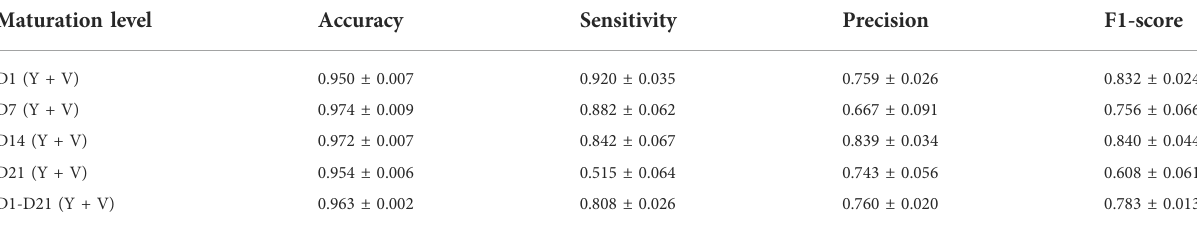
TABLE 1 Performance of the trained classi fi er. The classi fi er was evaluated in terms of its accuracy, sensitivity, precision, and F1-score on the whole testdatasetaswellasontheseparatedtestdatasetsforeachindividualmaturationlevel.Theclassi fi erwasvalidatedusing5-foldcrossvalidation (mean ± SD).